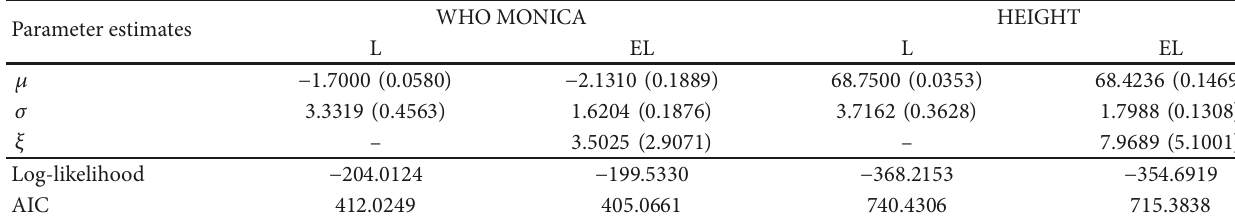
Table 4: Maximum likelihood estimation and standard error.